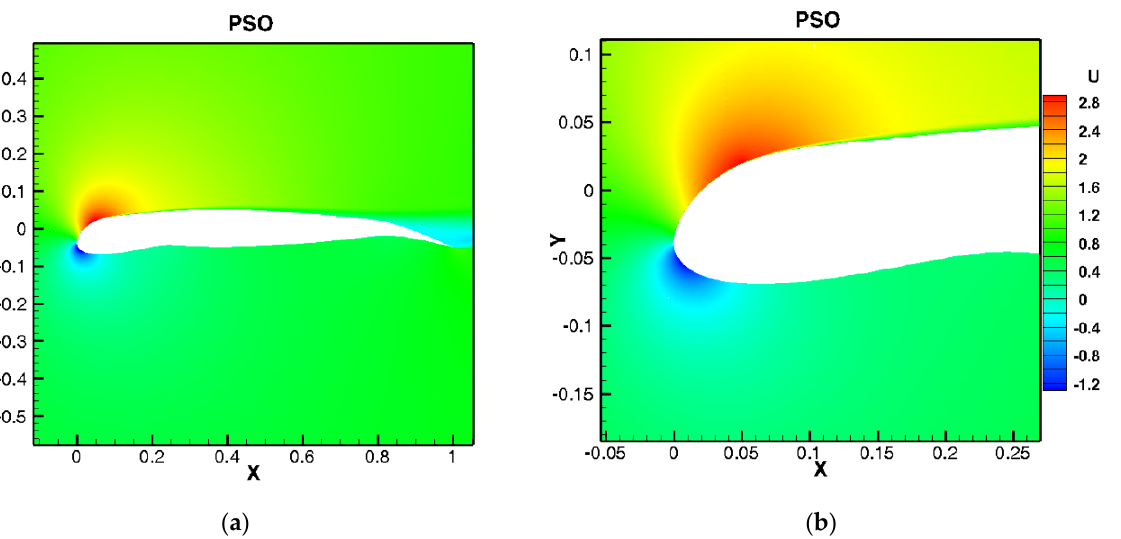
Figure 15. ( a ) Velocity flow field of the PSO-airfoil at AoA = 19° which corresponds to the C L,max . Velocities are normalized with the free stream velocity of 75 m/s. ( b ) Focus on the LE region.